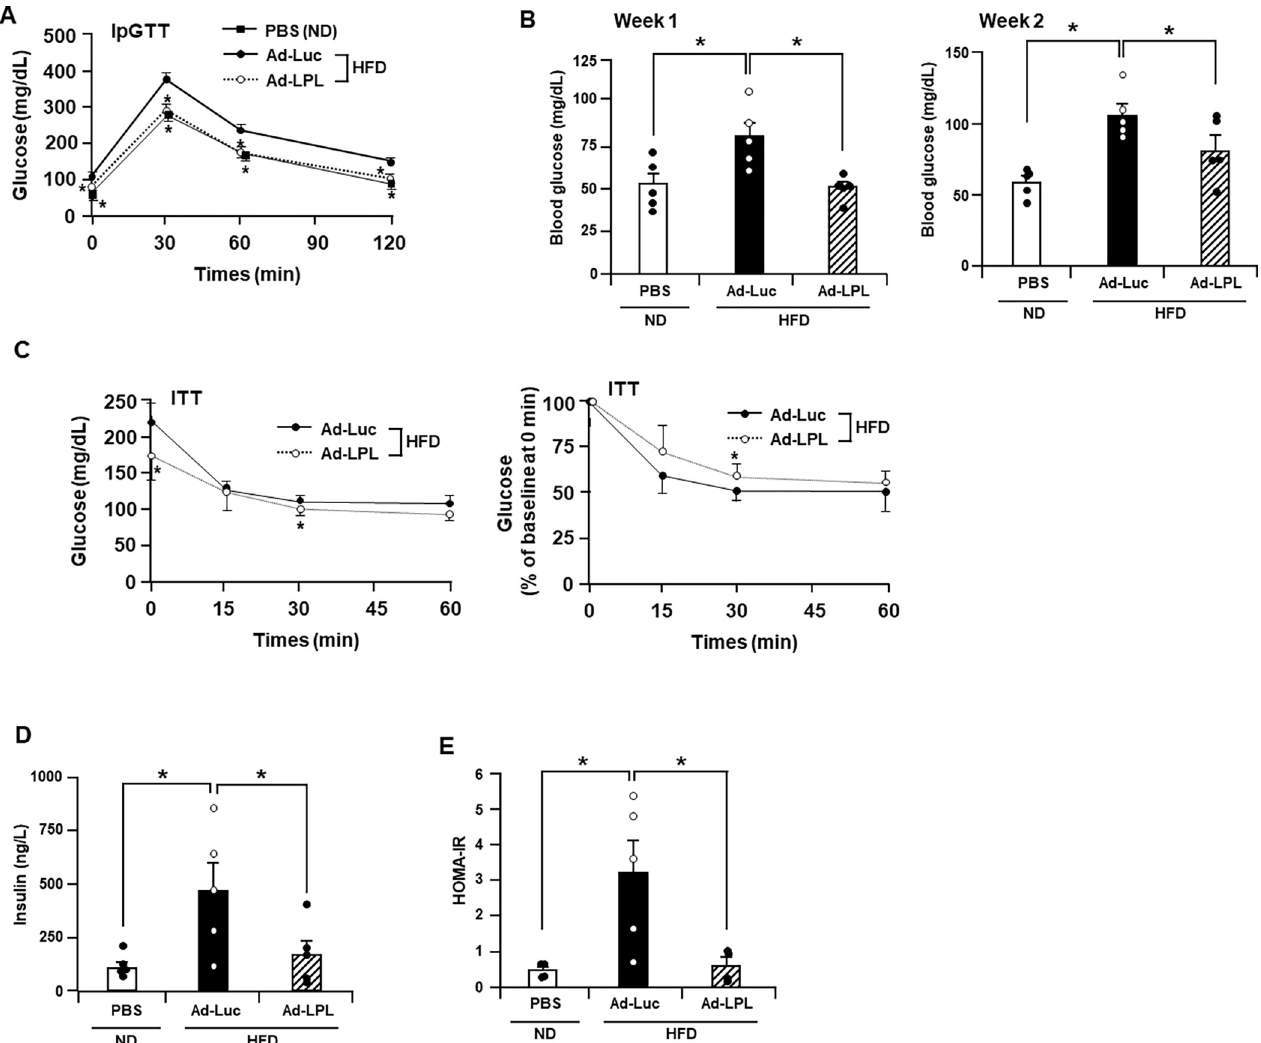
Fig 2. Hepatic LPL overexpression improves glucose metabolism and insulin resistance in HFD-fed mice. Male C57BL/6 mice were intravenously treated with Ad vectors via the tail vein and were simultaneously fed HFD. PBS-treated mice were fed ND throughout the experimental period. (A) Blood glucose levels during the intra-peritoneal glucose tolerance test of mice 2 weeks after administration of Ad-LPL, Ad-Luc, or PBS. (B) Fasting blood glucose levels of mice 1 and 2 weeks after administration of Ad-LPL, Ad-Luc, or PBS. (C) Blood glucose levels during the intra-peritoneal insulin tolerance test of mice 2 weeks after administration of Ad-LPL, Ad-Luc, or PBS. (D) Fasting insulin levels and (E) HOMA-IR of mice 2 weeks after administration of Ad-LPL, Ad-Luc, or PBS. One-way ANOVA with Dunnett’s post hoc tests was used for multiple comparisons (A, B, D, and E). The Mann–Whitney U test was used to compare differences between two independent groups (C). The data are expressed as the mean ± standard error (n = 4–5). � , P < 0.05 in comparison with